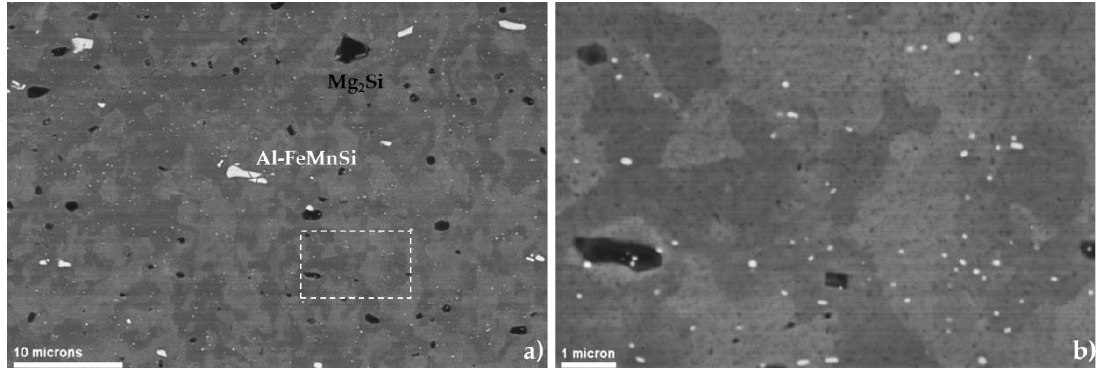
Figure 1. Microstructure of the as-received material observed by means of scanning electron microscopy (SEM) in backscattered electron mode (BSE) showing Al-FeMnSi (large and small) in white, and Mg 2 Si in black. ( a ) Overview and ( b ) detail of rectangle shown in ( a ).